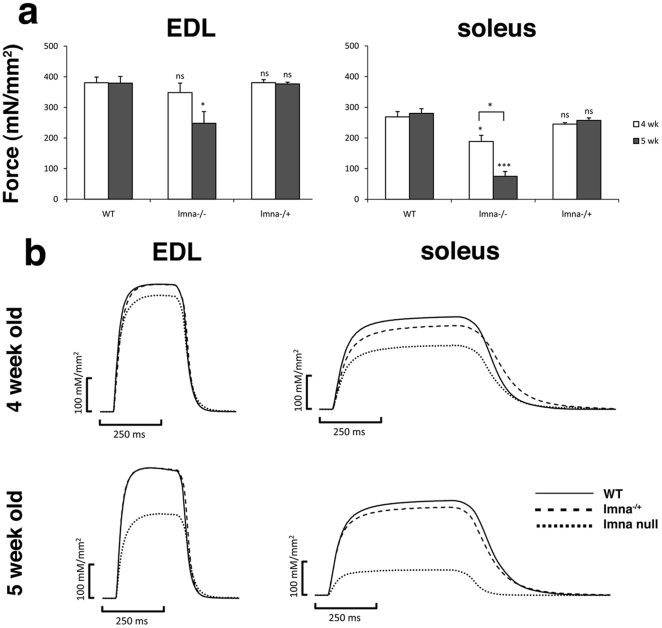
Force generation is impaired in EDL and soleus muscles lacking lamin A/C.Muscle specific force produced by EDL (left panel) and soleus (right panel) from wild-type (WT) lmna+/+, lmna
−/− and lmna
−/+ mice at 4 (white bars) and 5 (grey bars) weeks of age (a). Generation of isometric tetanic force at optimim length by EDL and soleus from WT (—), lmna
−/+ (---) and lmna
−/− (····) mice at 4 and 5 weeks of age (b). 3 muscles from 3 mice per genotype per age were analyzed. Values are mean ± SEM from three muscles. An asterisk denotes significance level using Student's t-test. *** p<0.001; * p<0.05; ns
p>0.05. Each value is compared with that of age-matched WT. The muscle specific force was also significantly different for soleus muscles from lmna
−/− mice between 4 and 5 weeks of age.